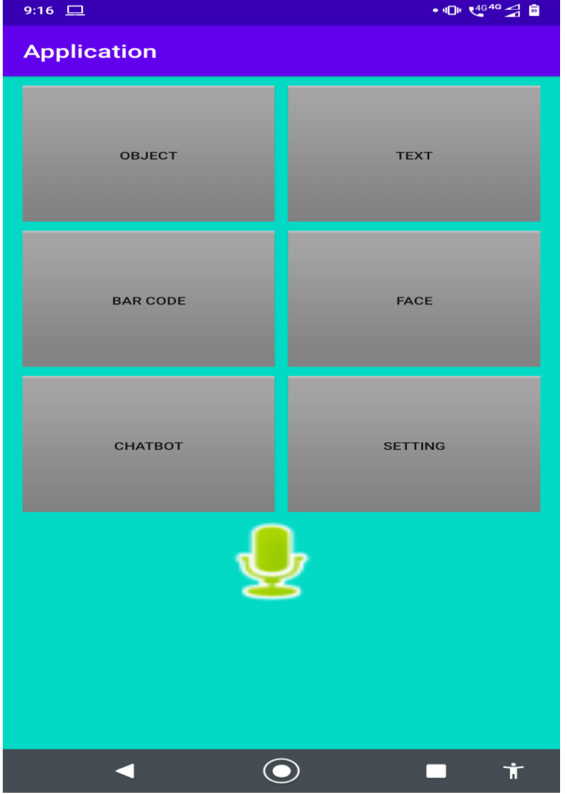
The system (referred to as the android app hereafter) consists of 5 modules-- real-time face detection, real- time object and text recognition, barcode scanner, and chatbot. Each of these modules can be easily accessed from the android app with the click of a button. The UI of the application has been designed to be user-friendly for partially blind.